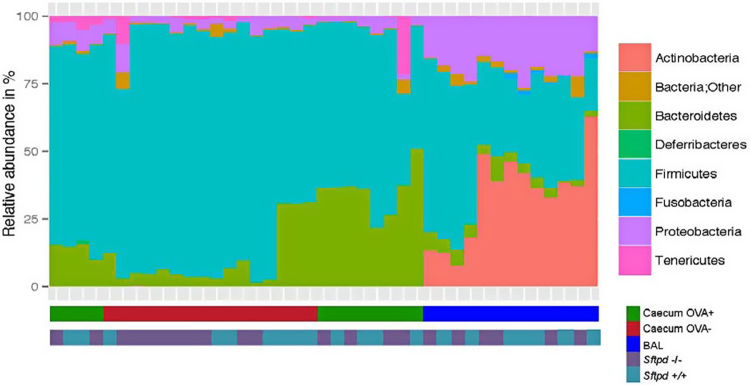
The overall phyla composition in caecal and BAL samples from individual C57BL/6 N female Sftpd+/+ and Sftpd-/- mice. Fig. 1 shows the phyla composition on the Y-axis as relative abundance. The 34 samples are clustered along the X-axis according to similarity between samples. The BAL samples are BLUE and the caecal samples are GREEN (OVA treated animals n = 16) or RED (for unchallenged animals n = 18). At the bottom, sample genotype is noted either Sftpd−/-, or Sftpd+/+, which shows no clustering. The caecal samples contained primarily Firmicutes, Bacteroidetes, Proteobacteria and minor occurrence of Tenericutes as well as Deferribacteres. In the BAL the bacterial community were composed of Actinobacteria, Firmicutes, Proteobacteria and Bacteroidetes together with Fusobacteria.